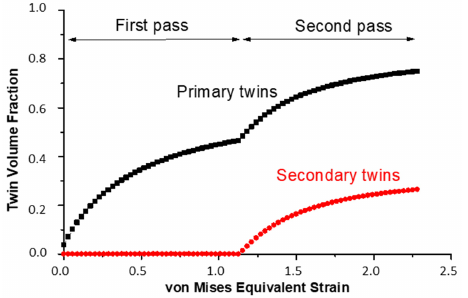
Figure 10. Simulated evolution of the twin volume fraction as a function of the von Mises equivalent strain during the first and second pass. Secondary twins were activated only from the start of the second pass. The twins take the form of lamellae and occupy 74% of the volume. They are also very hard (see Section 4.2) and interconnected. According to the microstructure observations, the twins constitute a